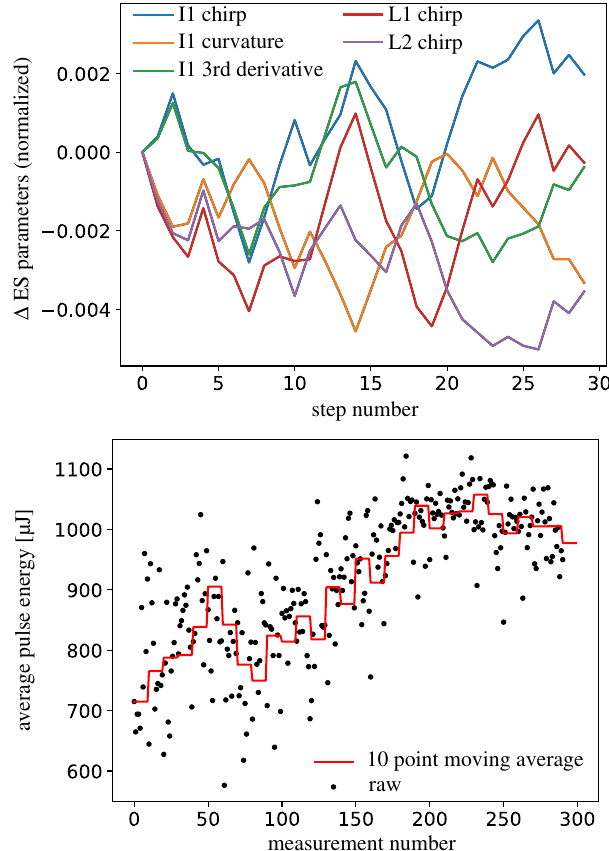
FIG. 2. Tuning 5 rf components to maximize average bunch energy.